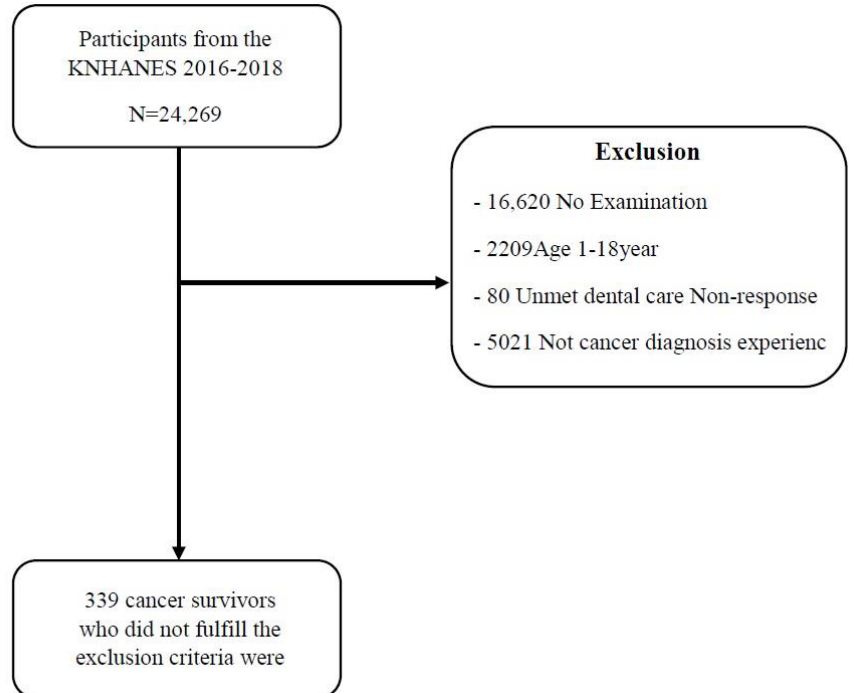
Figure 1. Participant flow diagram for final analysis.